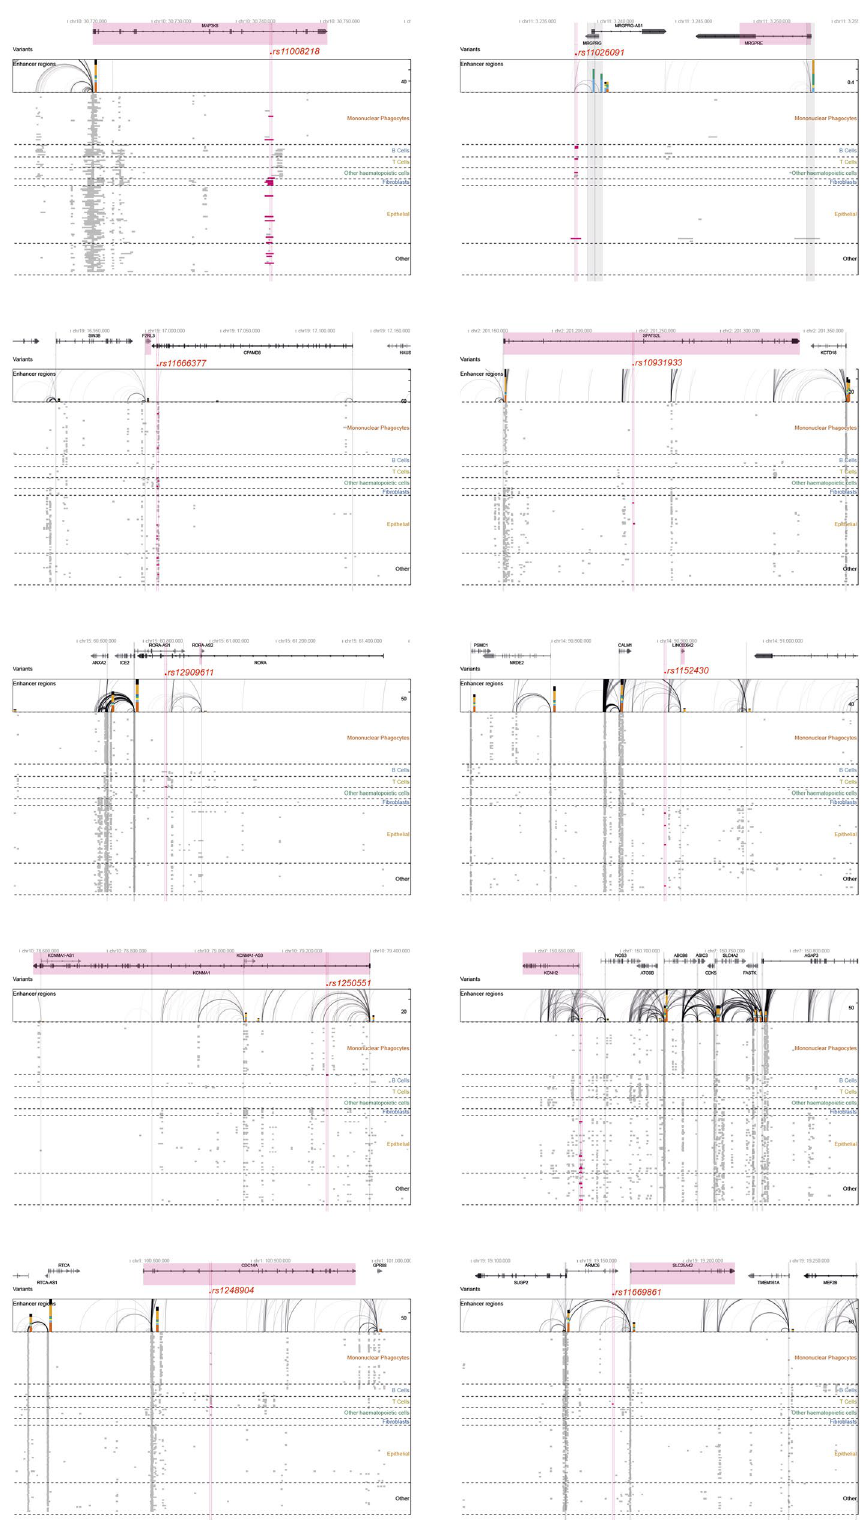
Figure 4. ABC gene-enhancer mapping of MS-trRNAs regulatory hotspots. The figure displays the positional mapping of selected MS-trRNAs-DBRs hotspots, their colocalization with regions encoding for regulatory elements active in specific cell types ( Mononuclear phagocytes, B cells, T cells, Other haematopoietic cells, epithelial cells, Other), and the enhancer-gene connections that determine the ABC mapping. The gene with the highest ABC score for each hotspot is highlighted in